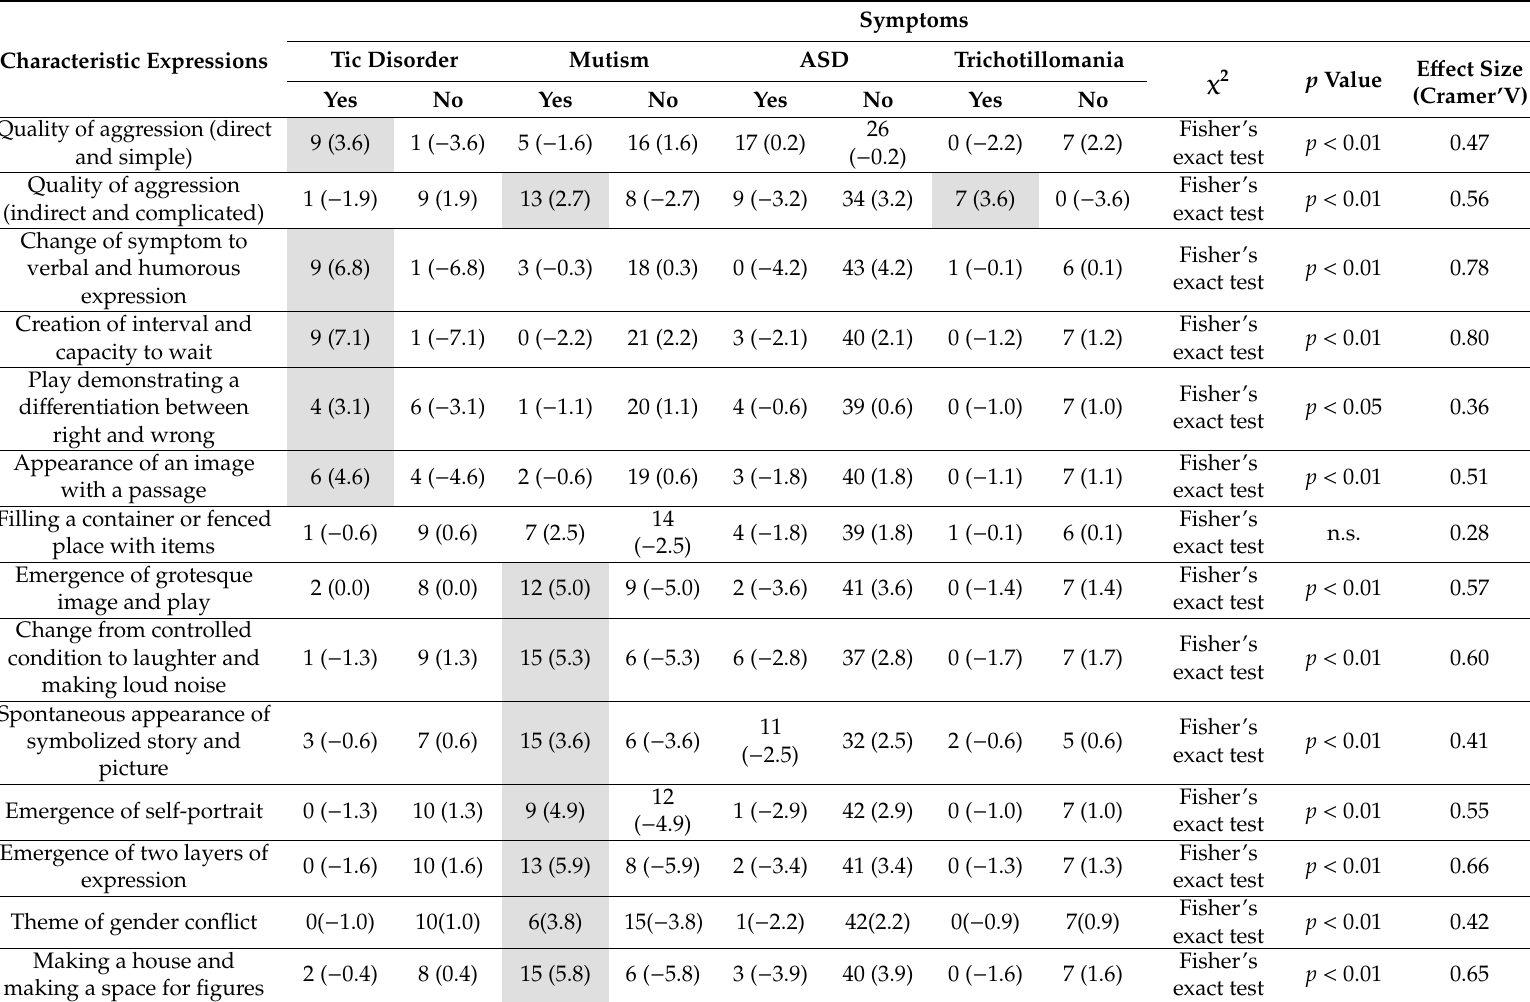
Table 3. The appearance of characteristic expressions and changes in